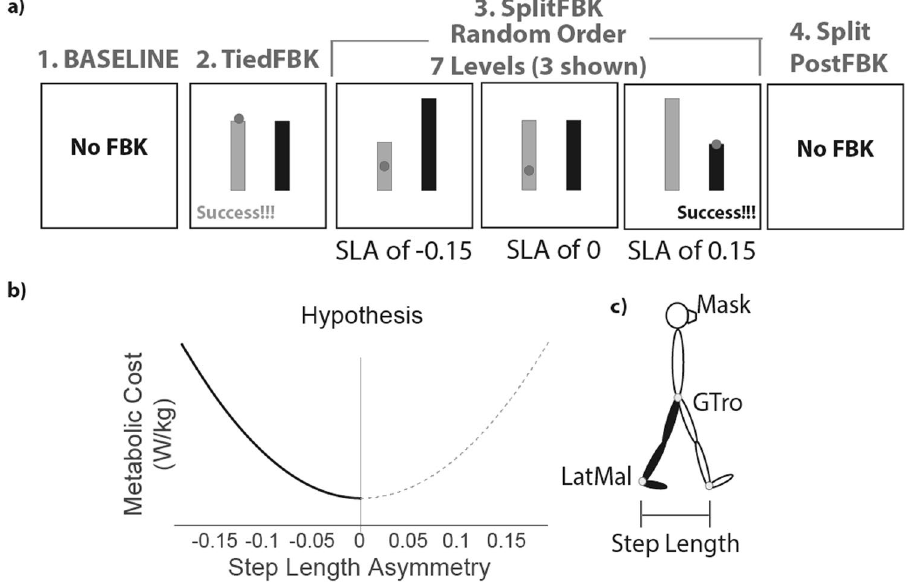
Figure 1. Experimental protocol. ( a ) Visual feedback for all experimental conditions, only three of seven trials of the step length asymmetry (SLA) used during SplitFBK are shown. The lateral malleoli markers were projected on the screen in real time during the swing phase to enable participants to achieve the desired step lengths. A “Success!!!” message appeared on the screen when foot strike occurred within two standard deviations of the desired target. ( b ) Hypothesized relationship between metabolic cost and step length asymmetry. Step length asymmetry values shown on the x-axis were those used as our targets in the SplitFBK trials. The dashed line indicates asymmetries not explored during natural adaptation. ( c ) Schematic of the experimental setup, with the mask used to measure metabolic cost and marker locations for measurement of step lengths. LatMal: Lateral malleolus and GTro: greater